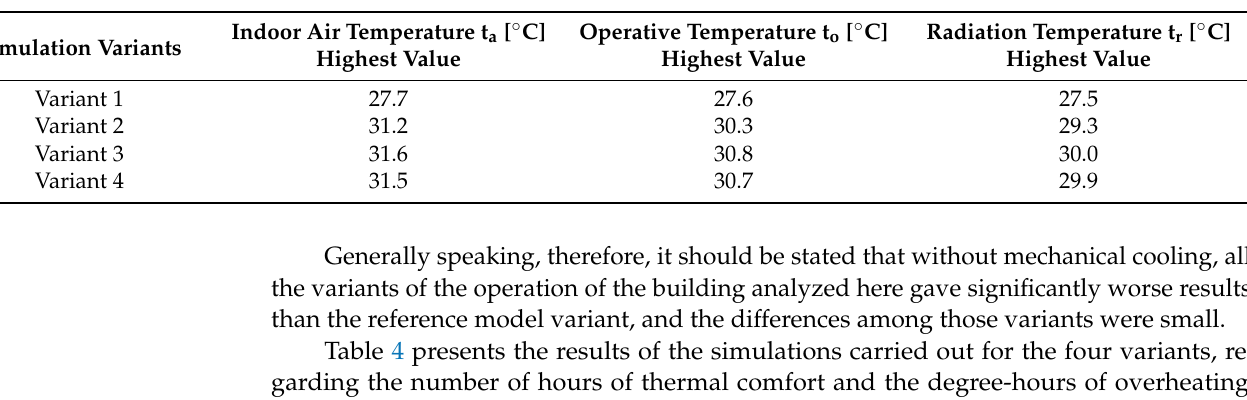
Table 3. Values of indoor air temperature, operative temperature, and radiation temperature for a two-month period of analysis of the simulation variants